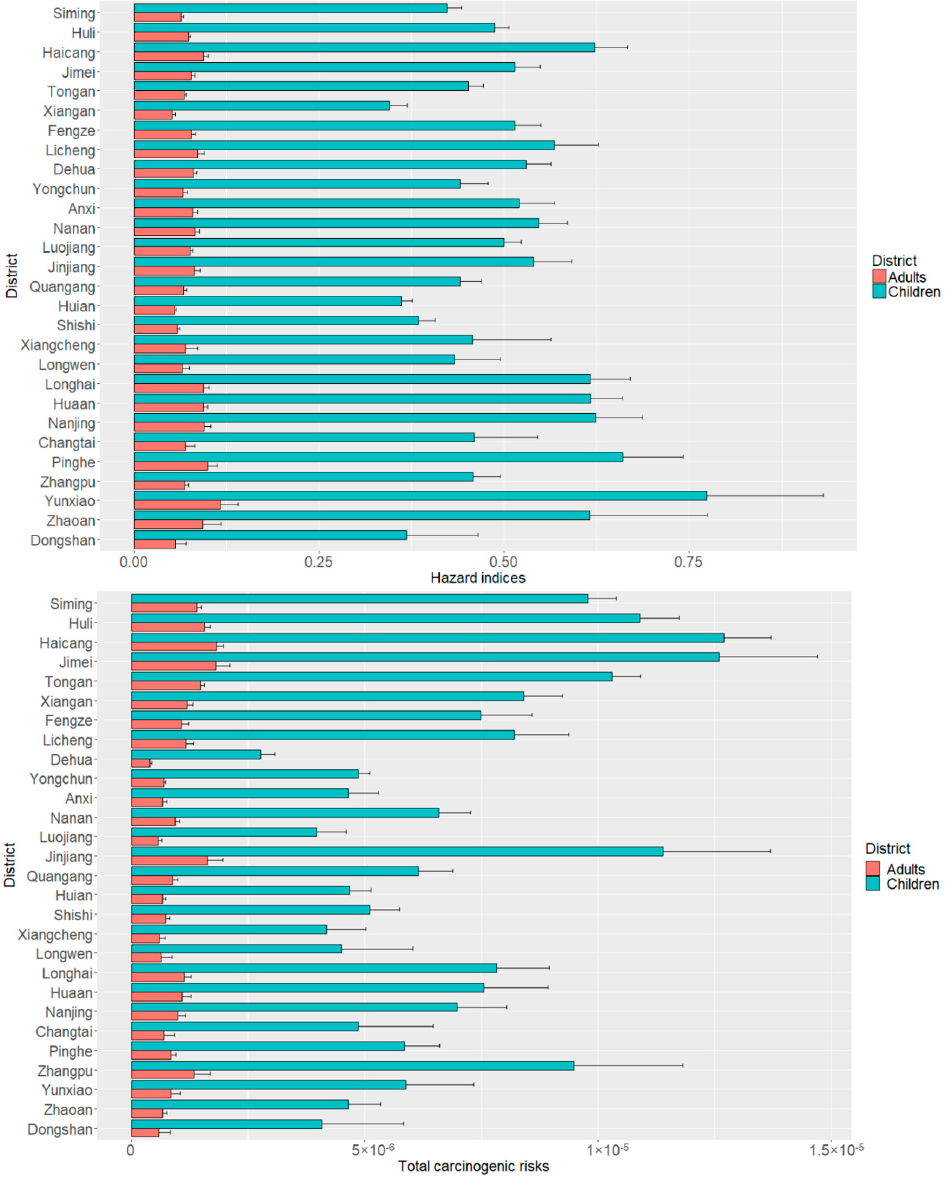
Figure 5. HI and TCR values for trace metals in the soils of different Golden Triangle districts. Table 3. PCA loadings and correlation coefficients of trace metals in the soils of the Golden Triangle. Principal Component Analysis Element